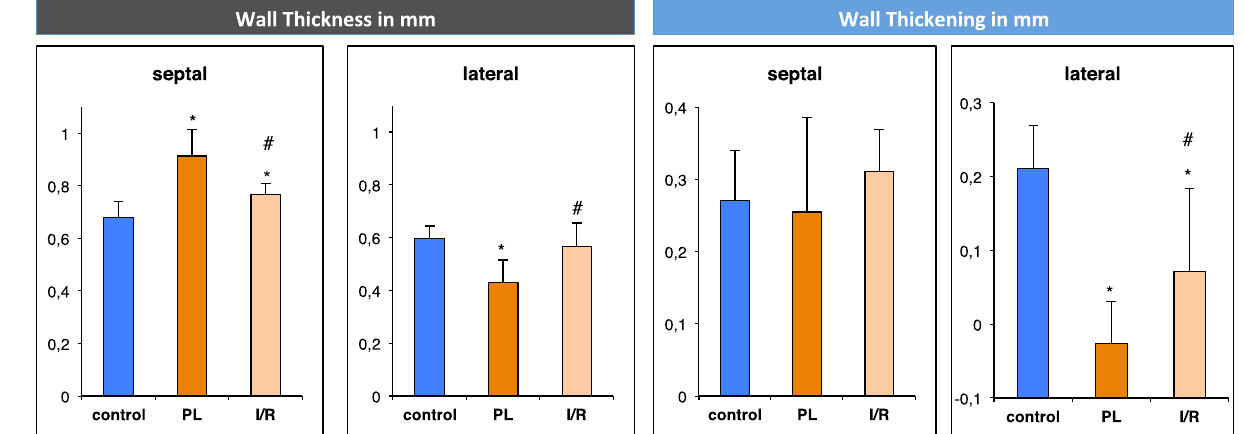
Figure 7. Regional wall analysis of short-axis slices 3–5. Wall thickness was assessed in end-diastolic images. Wall thickening is the difference between end-systolic and end-diastolic wall thickness. Values are mean ± SD. * p < 0.05 compared to control group. # p < 0.05 compared to PL group.